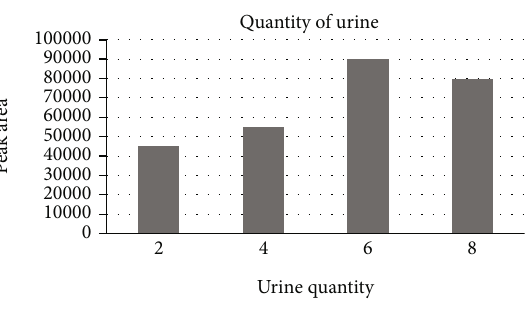
Figure 6: Graph of urine quantity.